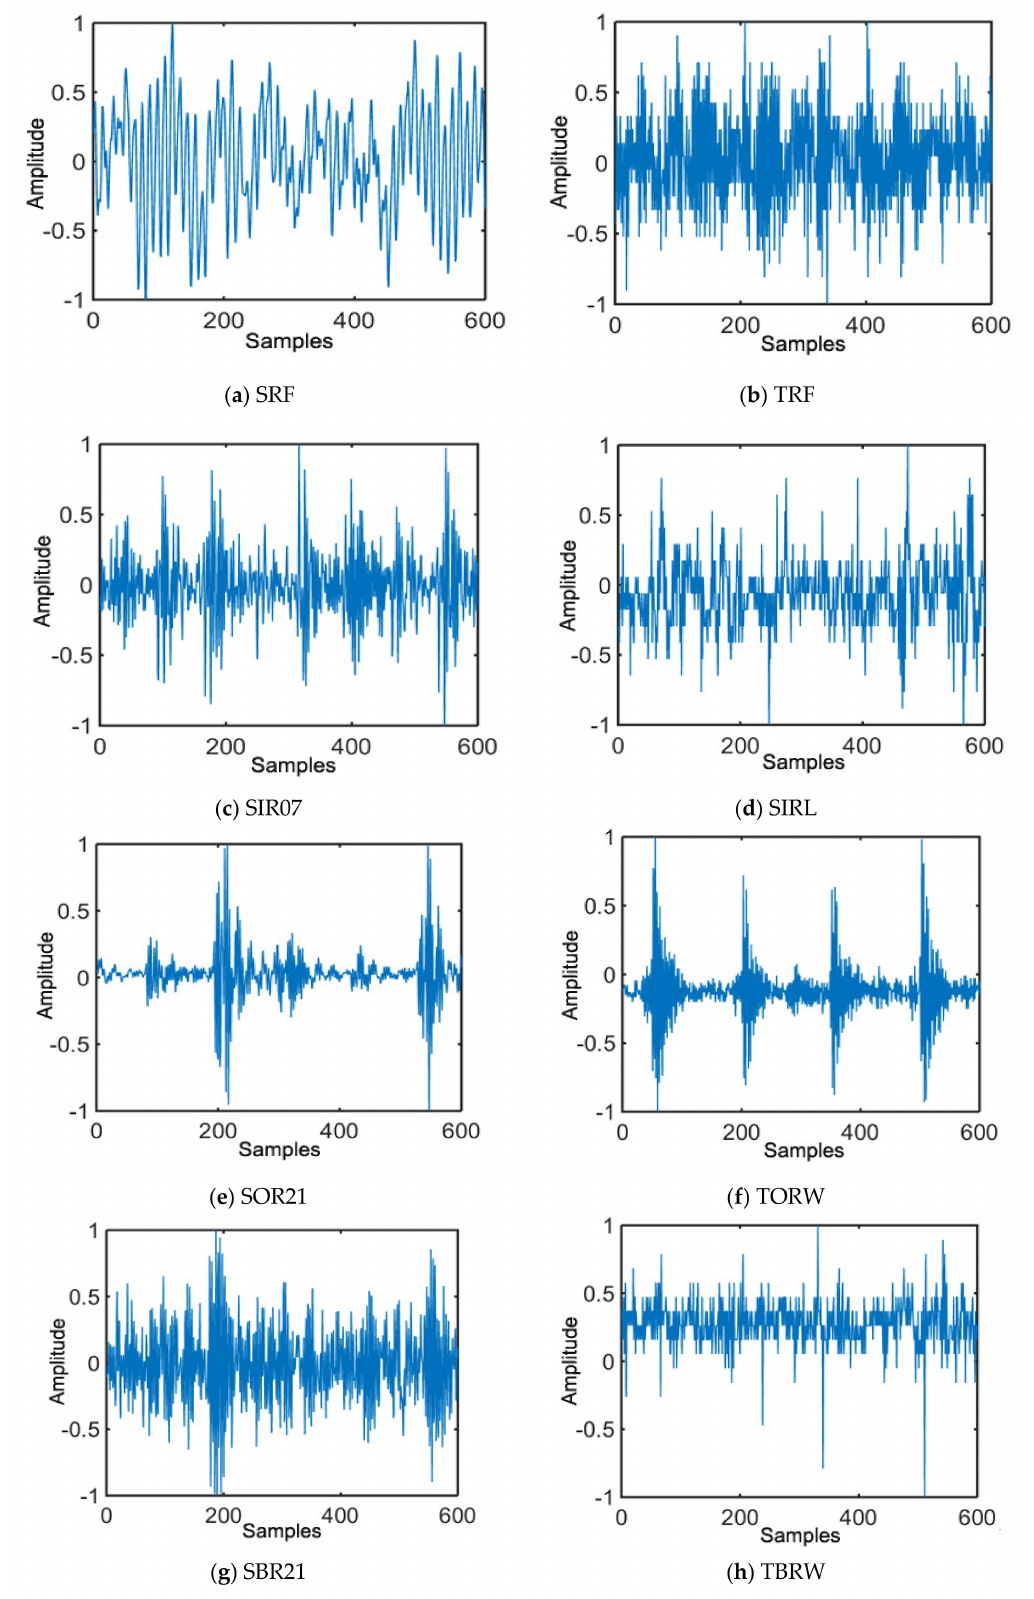
Figure 5. Comparison of source and target waveform samples under different working conditions. ( a , c , e , g ) diagrams of waveform samples under source regular family (SRF) and ( b , d , f , h ) waveform samples under target regular family